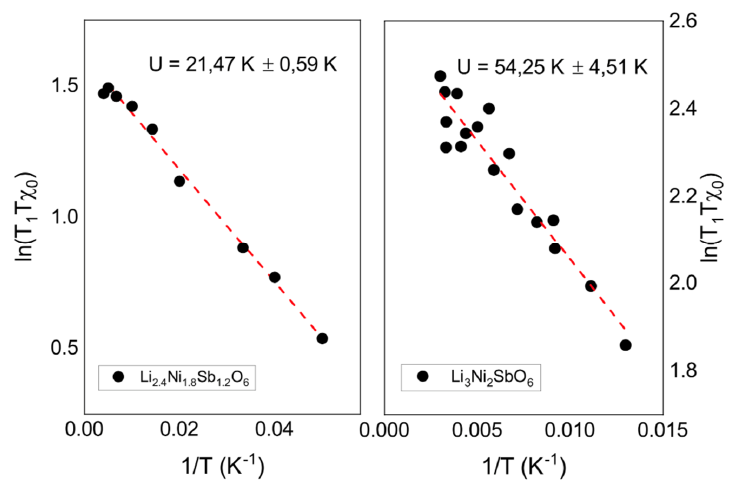
Figure 11. The ln( χ T 1 T ) curve as a function of inverse temperature for ( Left ) lithium deficient and Figure 11. The ln(χ T 1 T ) curve as a function of inverse temperature for Left ) lithium deficient and R ight ) stoichiometric samples. Red dashed lines are fits according to Equation (8). ( Right ) stoichiometric samples. Red dashed lines are fits according to Equation